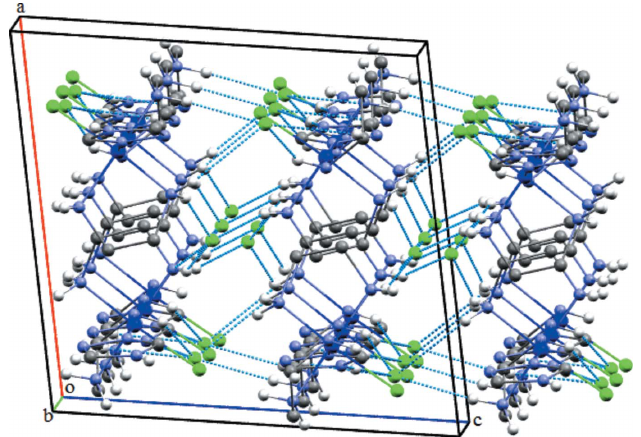
Figure 3 Partial packing diagram of the title structure viewed parallel to (100).